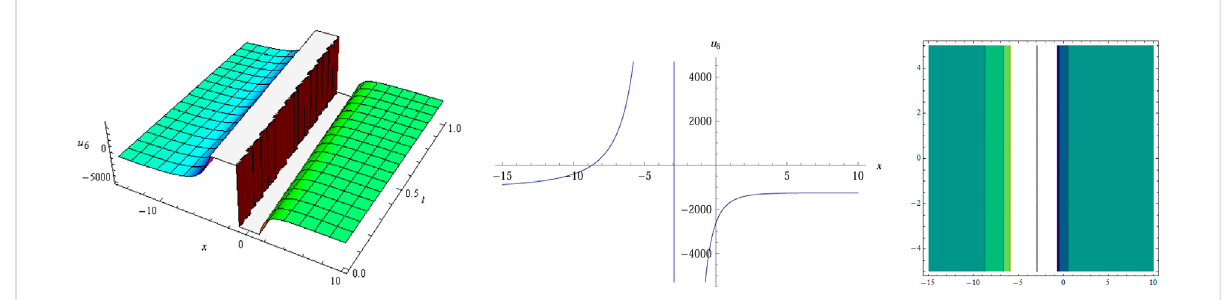
FIGURE 8 3D plot, 2D plot, and contour plot of u 6 with α (cid:2) β (cid:2) 1.